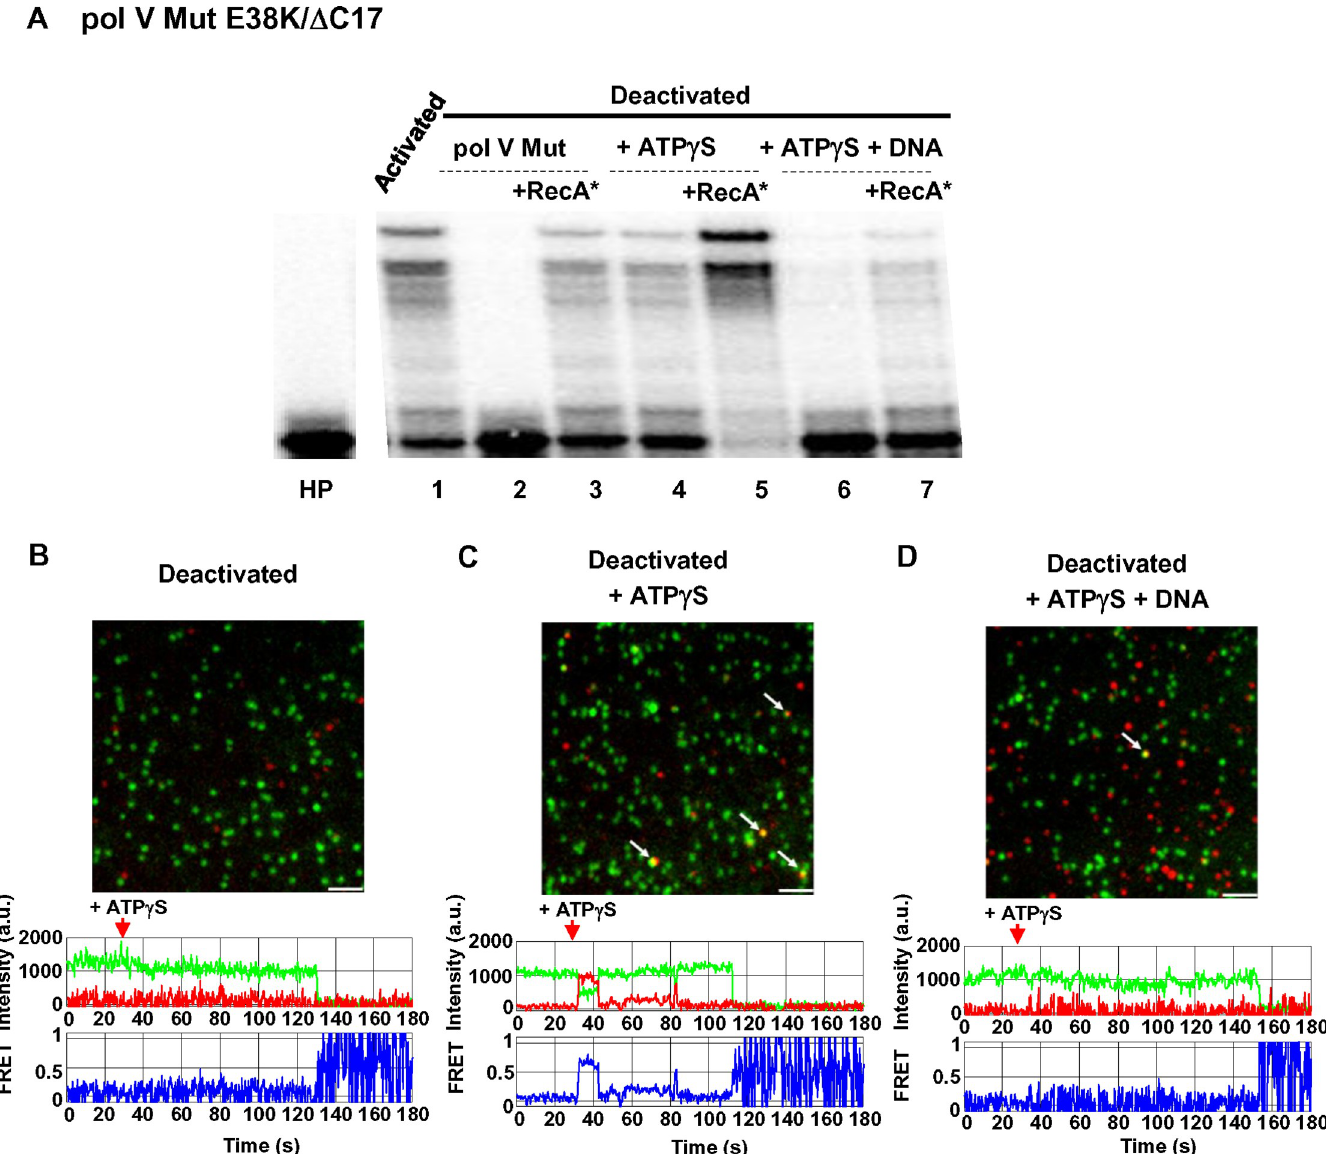
Fig 8. Deactivated pol V Mut E38K/ Δ C17 does not bind to p/t DNA. (A) Pol V Mut was assembled using AF647-labeled RecA E38K/ Δ C17. To deactivate pol V Mut AF647 E38K/ Δ C17, 1 μ M of enzyme was incubated either alone (lane 2), or with ATP γ S (500 μ M) (lane 4), or with ATP γ S (500 μ M) and p/t DNA (5 μ M) (lane 6) for 4 hr at 37 o C. After incubation, the activity of pol V Mut E38K/ Δ C17 AF647 was measured on 32 P-labeled 12 nt oh HP DNA in the presence of ATP γ S (A), and binding to p/ t DNA was detected in smFRET experiments (B-D). Statically deactivated pol V Mut E38K/ Δ C17 AF647 cannot incorporate dNTPs after 4 hr incubation at 37˚C (A, lane 2). ATP γ S stabilizes pol V Mut E38K/ Δ C17 AF647 and protects it from deactivating (A, lane 4). However, deactivation does occur following the addition of DNA to ATP γ S-bound pol V Mut AF647 E38K/ Δ C17 (A, panel 6). Deactivated pol V Mut E38K/ Δ C17 AF647 can be reactivated by RecA � (lanes 3, 5, 7). Pol V Mut E38K/ Δ C17 AF647 that has not been subject to incubation at 37˚C (4 hr incubation on ice) is able to synthesize DNA in the presence of ATP γ S (lane 1). (B-D) Representative smFRET images depicting binding of deactivated pol V Mut E38K/ Δ C17 AF647 to p/t DNA. AF555-labeled p/t DNA is shown in green, pol V Mut E38K/ Δ C17 AF647 is shown in red. Binding events are shown as colocalized pol V Mut E38K/ Δ C17 AF647 and p/t DNA yellow/orange signals and are marked with arrows. Representative smFRET trajectories are shown below each deactivation panel (B-D). No DNA binding events are detected for deactivated pol V Mut E38K/ Δ C17 AF647 (B), which is consistent with the absence of polymerase activity (A, lane 2). Pol V Mut E38K/ Δ C17 AF647 activity is stabilized substantially in the presence of ATP γ S, which results in DNA binding (C) and polymerase activity (A, lane 4). Fewer binding events are detected when pol V Mut E38K/ Δ C17 AF647 is incubated in the presence of ATP γ S + p/t DNA (D) compared to incubation with ATP γ S in the absence of DNA (B, middle panel). For all smFRET binding assays, ATP γ S (500 μ M) was added prior to injection of labeled pol V Mut. The images shown in (B-D) panels correspond to smFRET data integrated over 1 min. Scale bar is 150 mm.